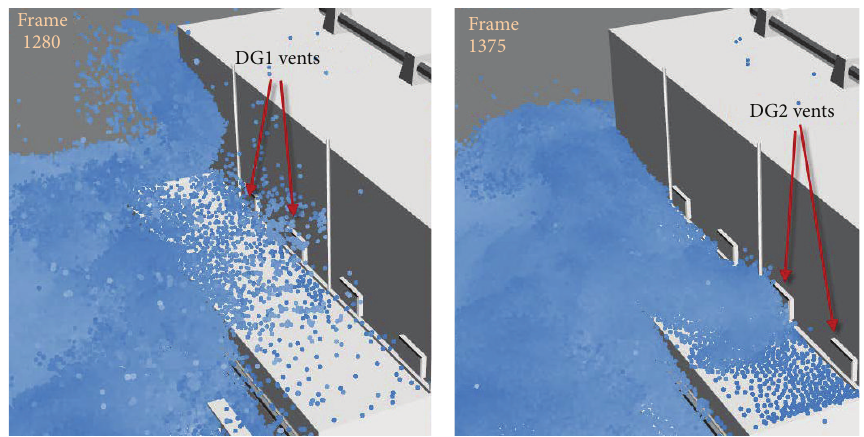
Figure 11: Time spacing between failures of generators due to fluid in the air intake vents of the generator room.